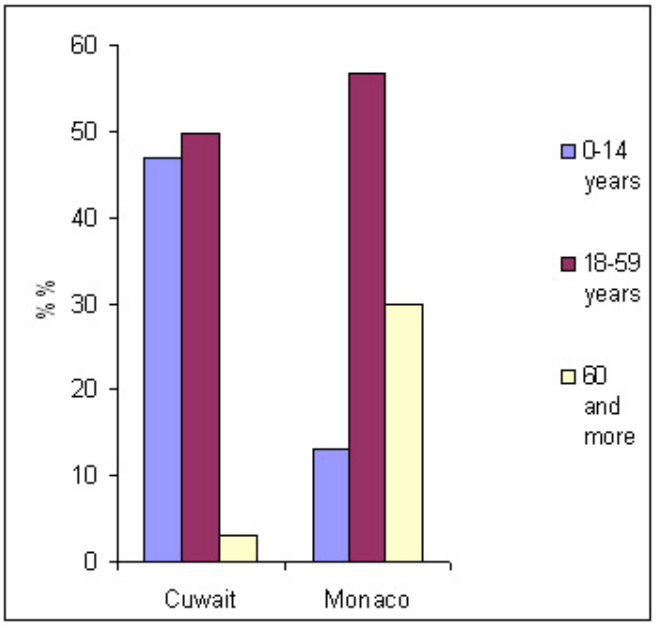
FIGURE 10 . Different age structure of two human